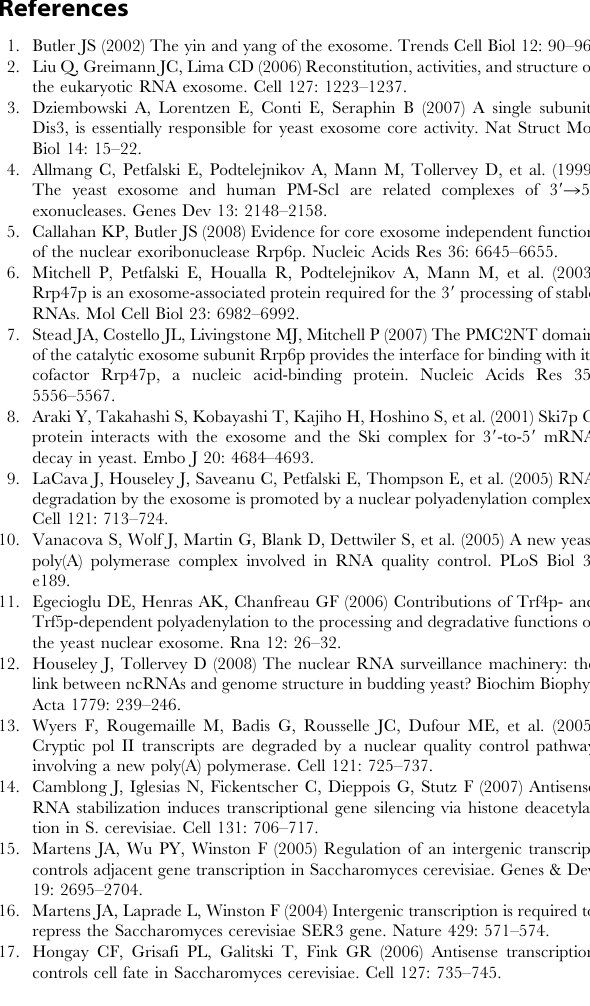
Table S3 List of the peptides identified by mass spectrometry with scores for identified